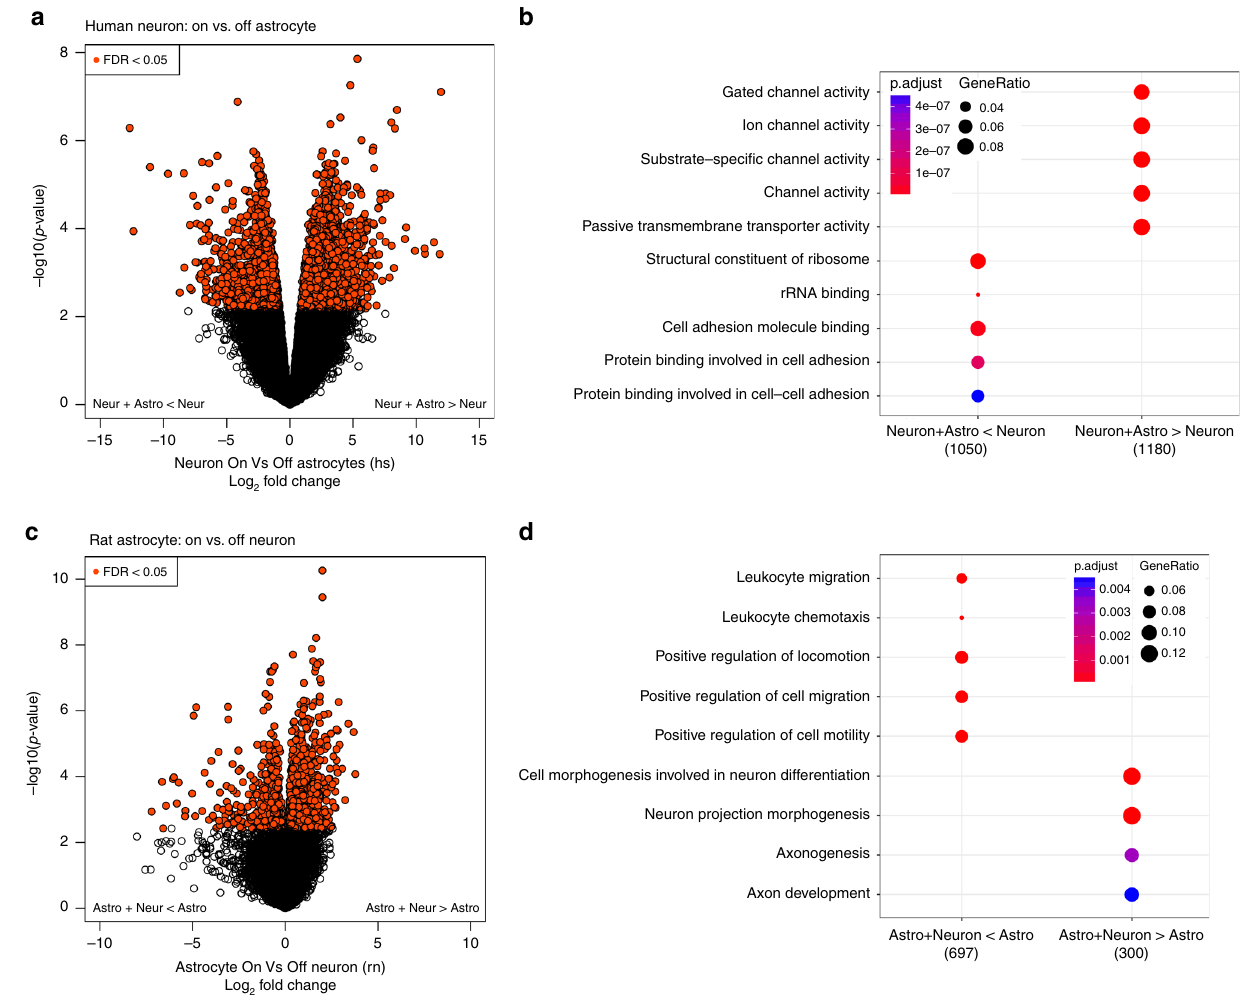
Fig. 4 Astrocyte coculturing. a Volcano plot showing the differential expression between human neurons cultured alone and human neurons cocultured with rat astrocytes, as well as the enrichment b of the 3214 genes differentially expressed at FDR < 5%, split by direction of change. c , d Analogous results of differential expression analysis quanti fi ed against the rat genome, comparing rat astrocytes alone with rat astrocytes cocultured with human